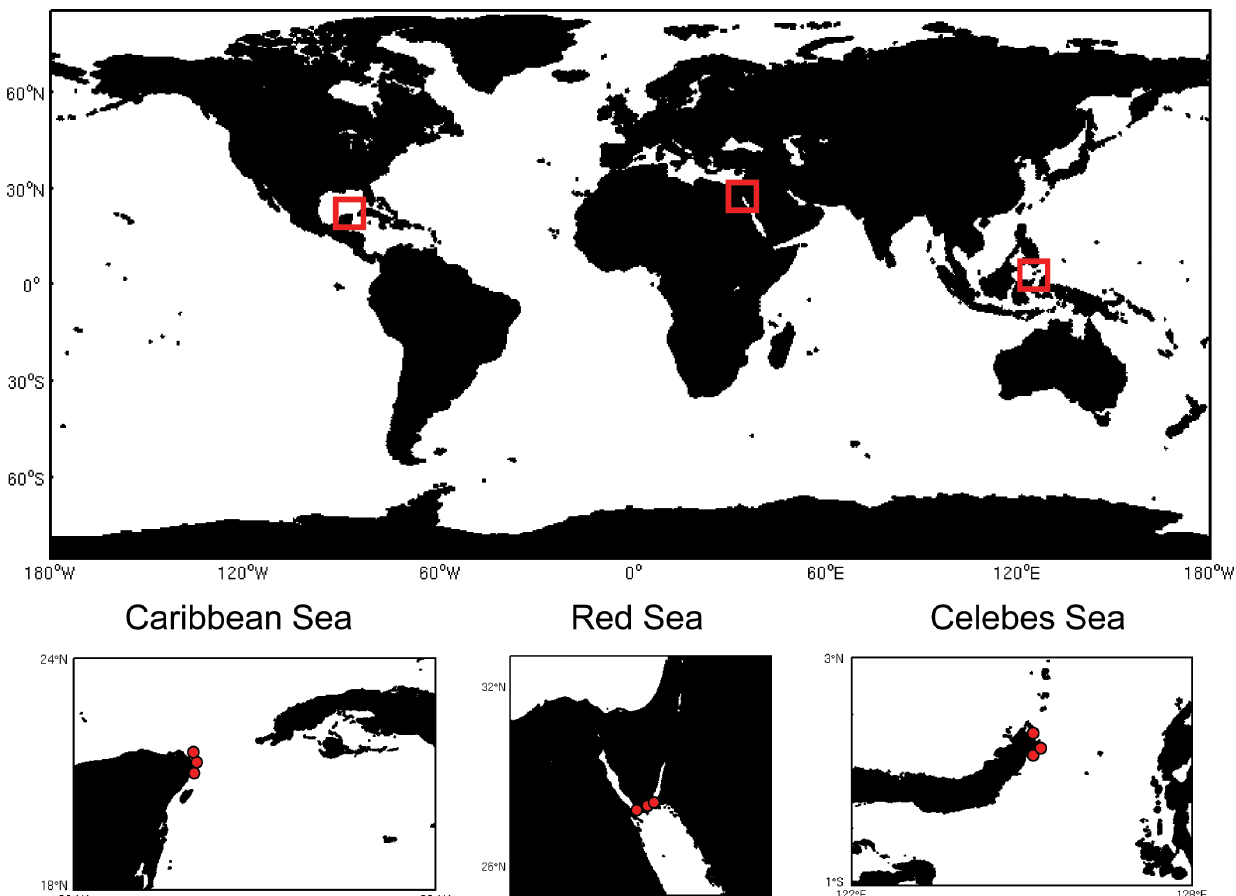
Figure 1. Sampling areas and location of the investigated regions with details of the positioning of each habitat type.